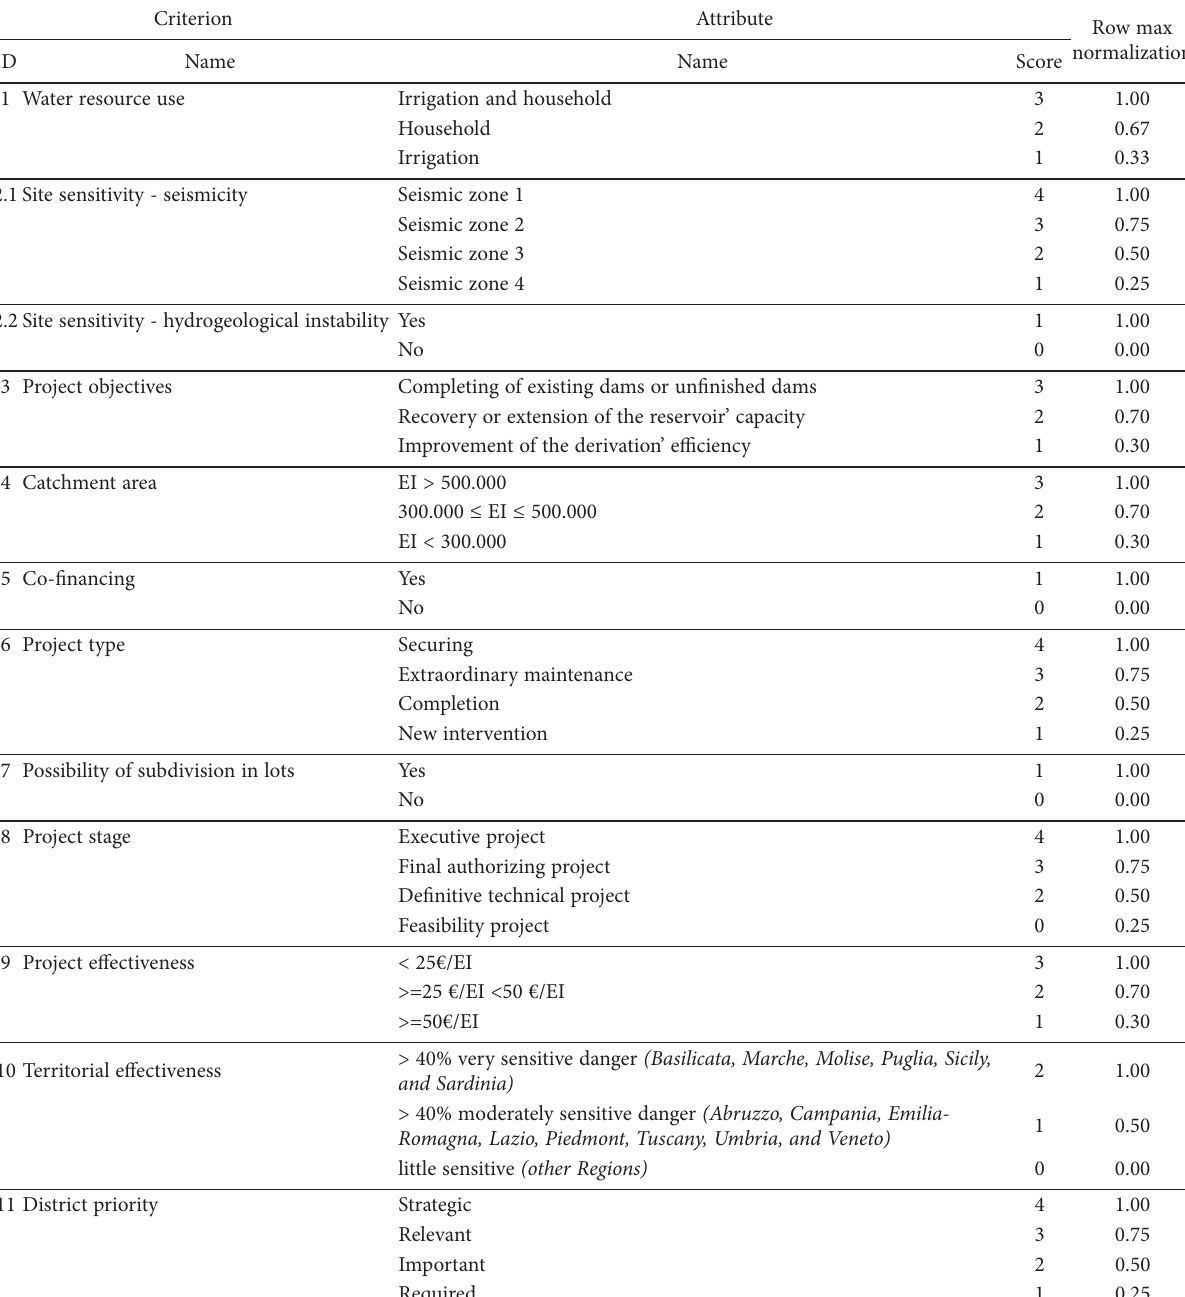
Table 3. Attributes and their scores. Row max normalization refers to normalization carried out before sensitivity analysis.